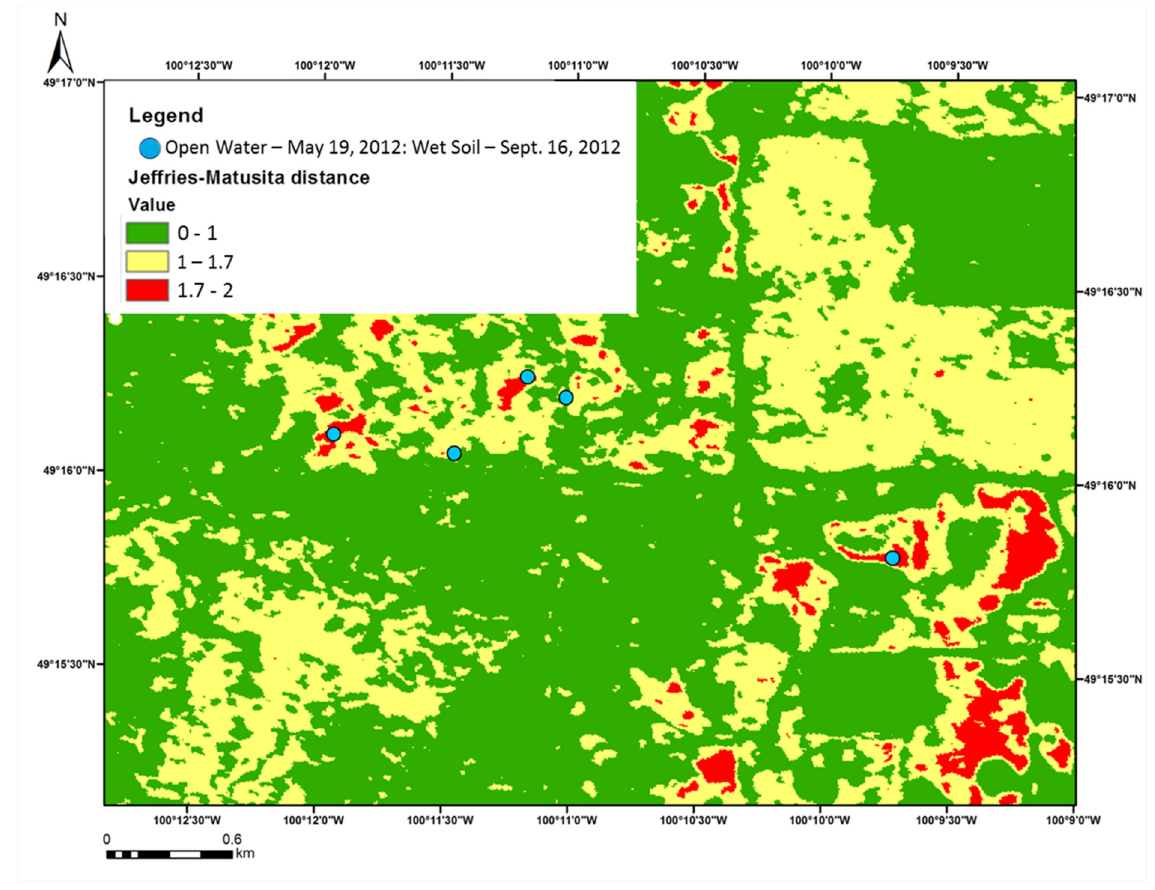
Figure 13. Areas of open water on 19 May 2012, that became wet soil by 16 September 2012, are indicated by the blue dots. The background image is the Wishart-Chernoff Distance calculated using fully polarimetric data from the two dates. Red polygons are areas estimated to have high amounts of change; yellow areas signify moderate change; and green areas signify little or no